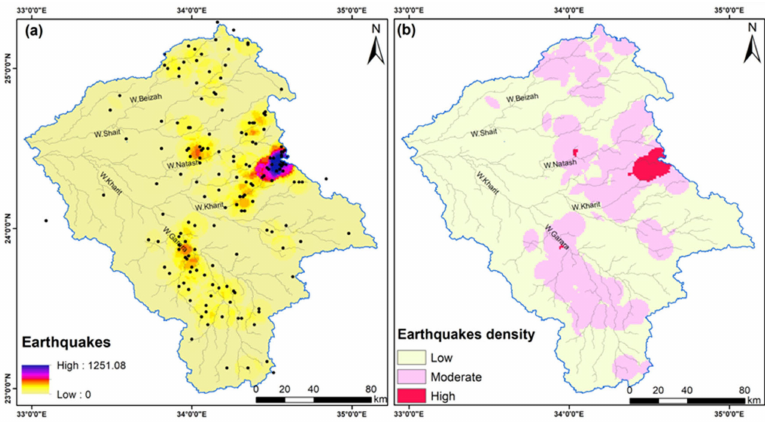
Figure 12. Earthquake data: ( a ) distribution of earthquakes locations; ( b ) density of earthquakes.